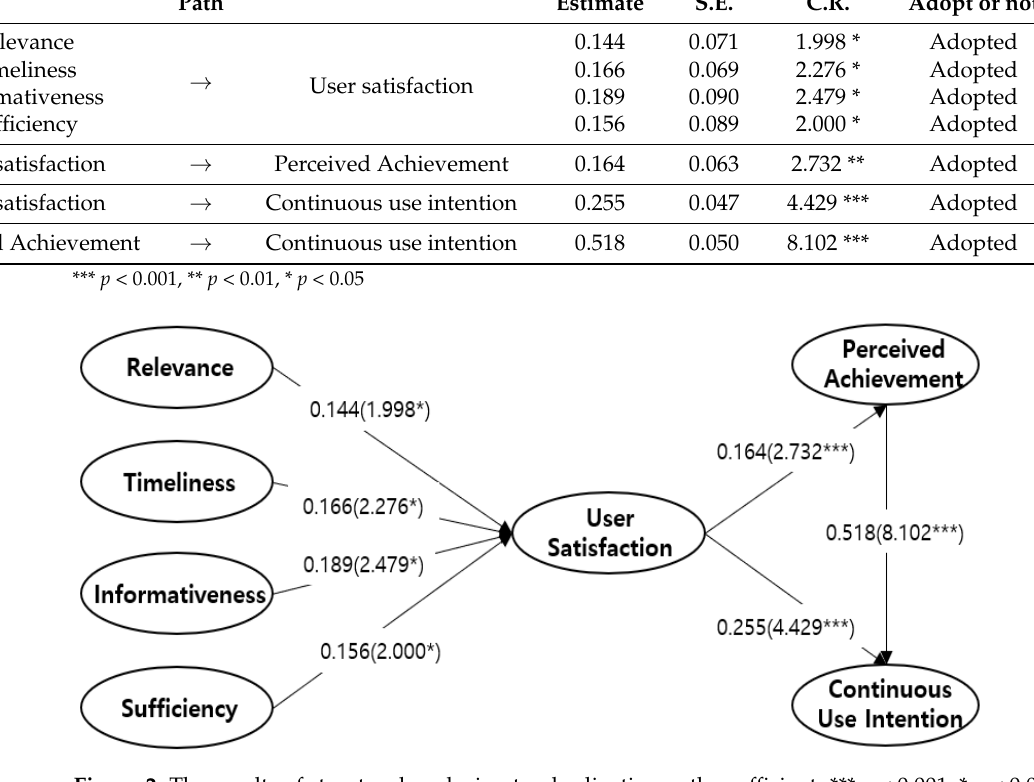
Figure 2. The results of structural analysis: standardization path coefficient. *** p < 0.001, * p <